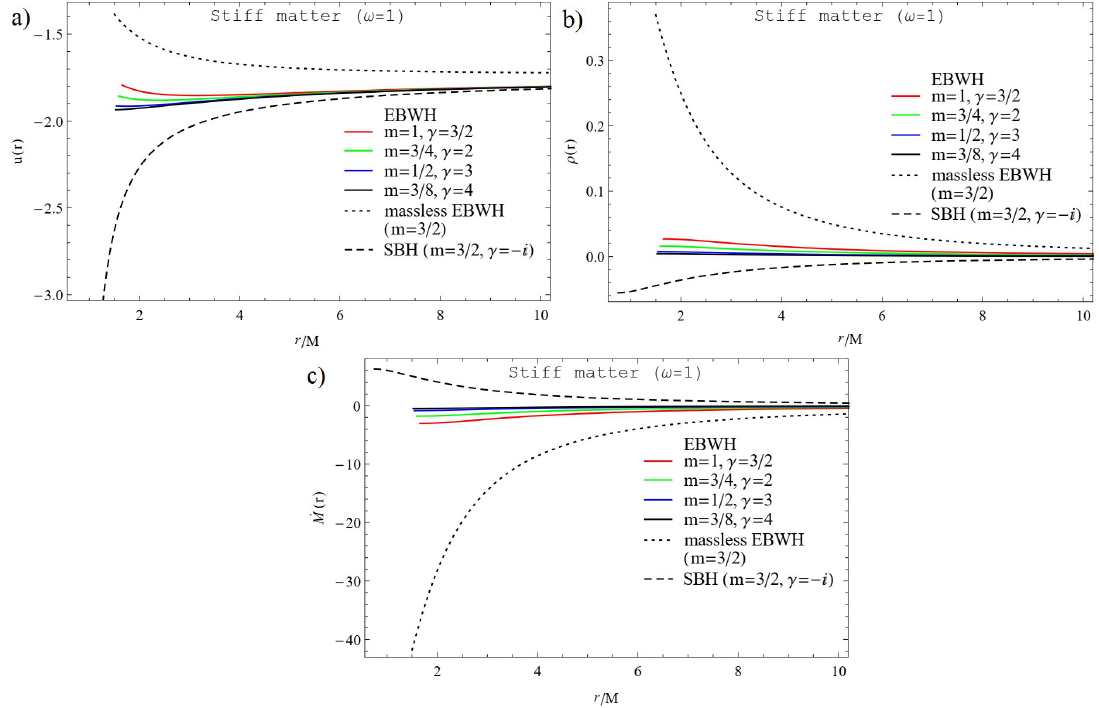
Figure 4. Velocity profile ( a ), energy density ( b ) of stiff matter ( ω = 1), and rate of change of mass ( c ) of EBWH versus r for different values of γ and m , which satisfies M = m γ = 3/2. For illustration, we used set of constants A 0 = and A 4 = 4.